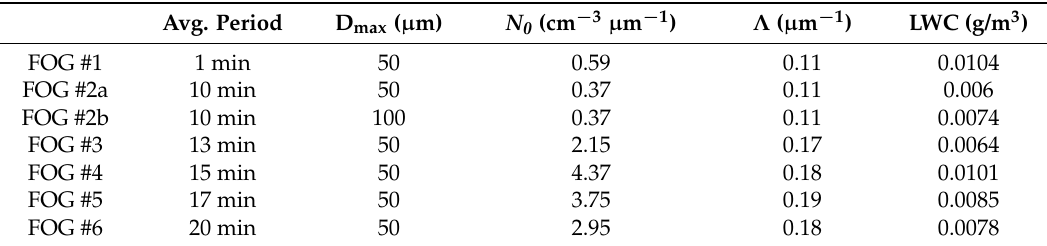
Table 2. Fitting parameters of the negative exponential distribution characterizing the fog droplet spectra and their liquid water content (LWC) for different averaging periods before the onset of the rainfall event on 1 October 2015. Note N 0 represents the intercept and Λ represents the slope. Avg.